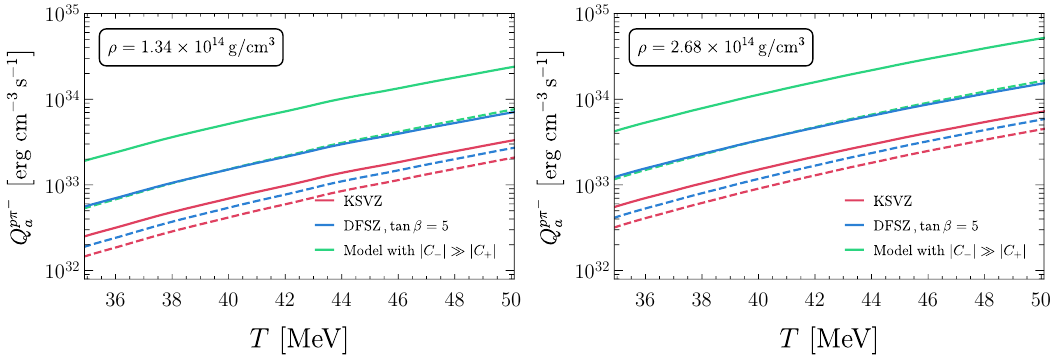
Figure 3 . Axion emissivities of π − + p → n + a for the KSVZ, DFSZ, and a model with | C − | (cid:29) | C + | . All models are assumed to have f a 9 ≡ ( f a /c G ) / 10 9 GeV = 1 . The solid curves represent the total emissivity including the effect of the contact interaction C aπN , while the dashed curves are the emissivity without including the contribution from C aπN